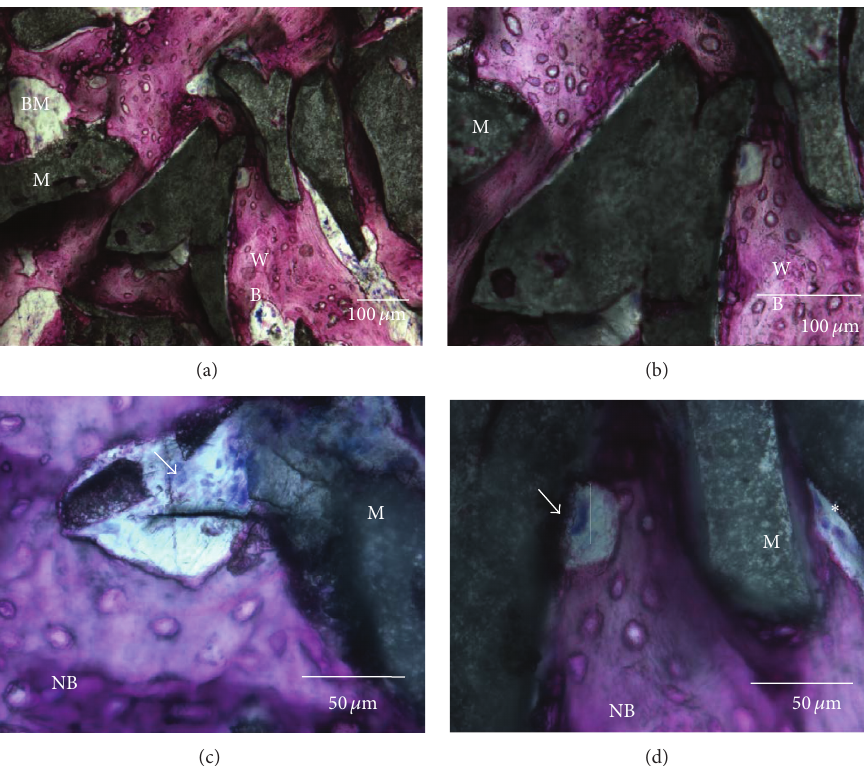
Figure 3: Representative light micrographs illustrating histological details of a defect grafted with BCP at 6 weeks after implantation. BCP surrounded and bridged by newly formed bone ((a); magnification × 10 and (b); magnification × 20)). Mostly newly formed bone had woven- bone (WB) characteristics (b); giant multinuclear cells (arrows) were observed on the BCP particles ((c) and Frame (d); magnification × 40). Stain: Giemsa-Paragon.